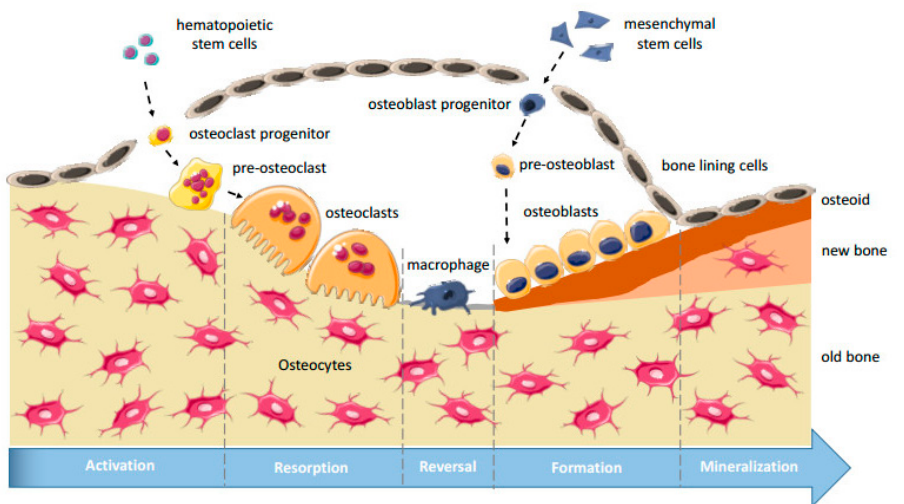
Figure 1. Schematic representation of the bone remodeling process. Bone lining cells are activated by the release of factors such as insulin growth factor ‐ I (IGFI), tumor necrosis factor ‐α (TNF ‐α ), parathyroid hormone (PTH), and interlueukin ‐ 6 (IL ‐ 6). Osteoclast cells then break down the organic and inorganic portions of old bone tissue, forming indents. Osteoblasts fill these indents and release a matrix which is then mineralized to form bone tissue. Reprinted with permission under a Creative Commons Attribution 4.0 International license from the Reference by Truesdell et al. [17]. Copyright 2020, AIMS Press.